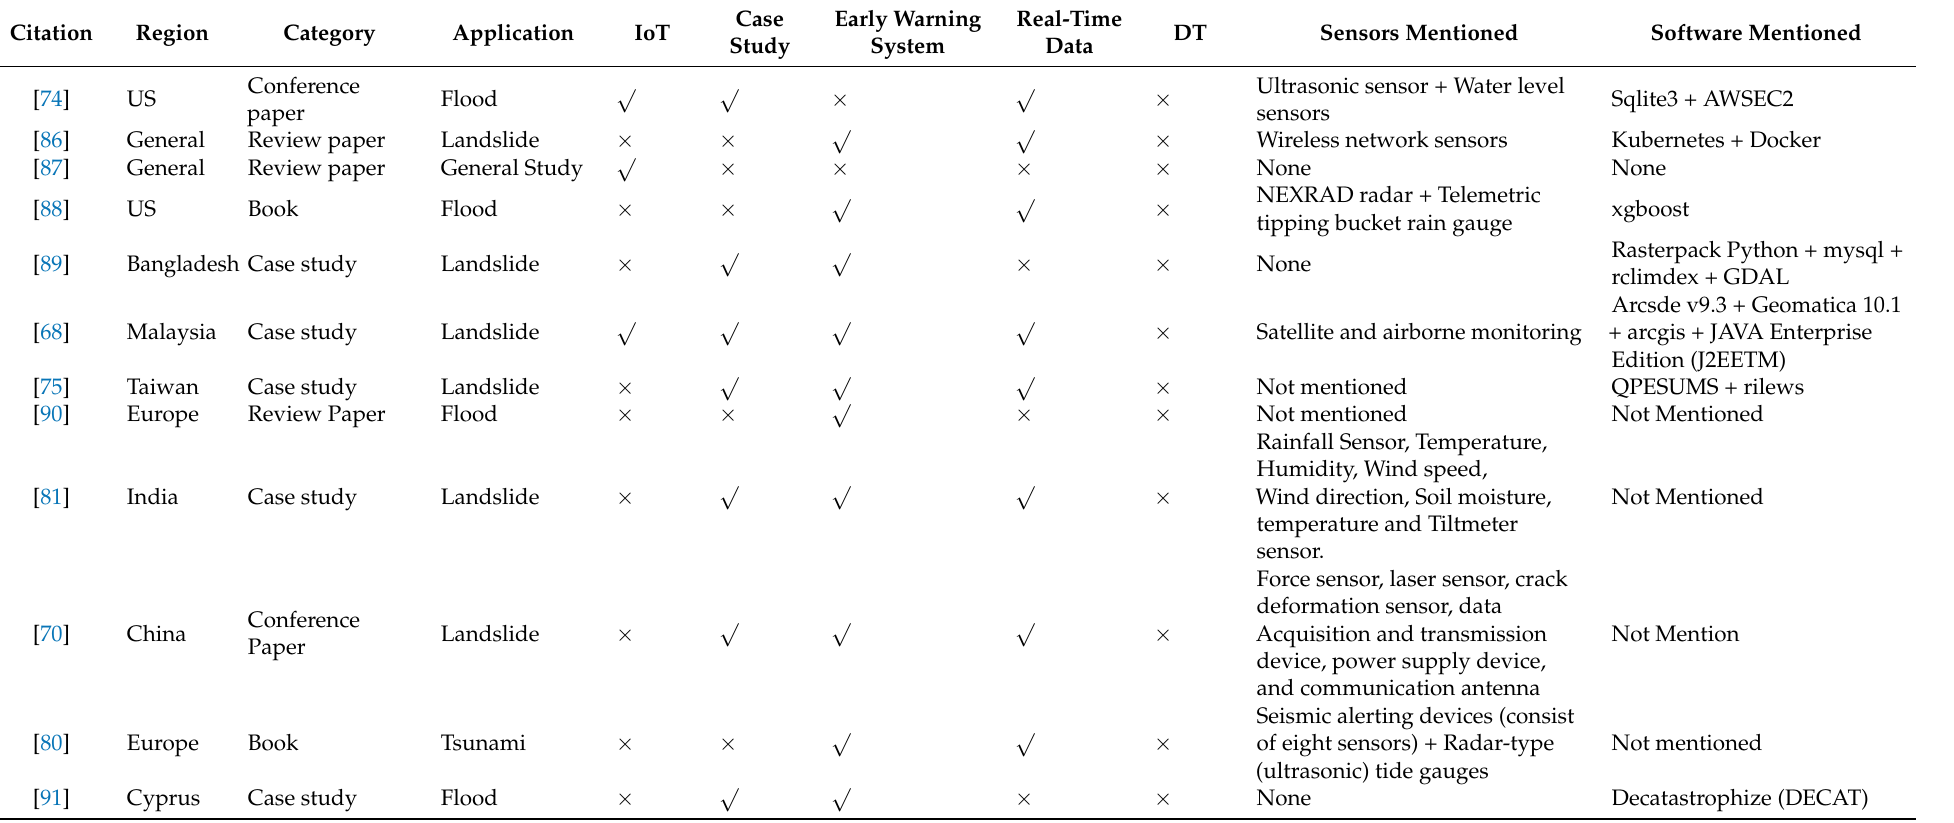
Table 3. List of eligible early warning system articles included in the review with their research objectives and other